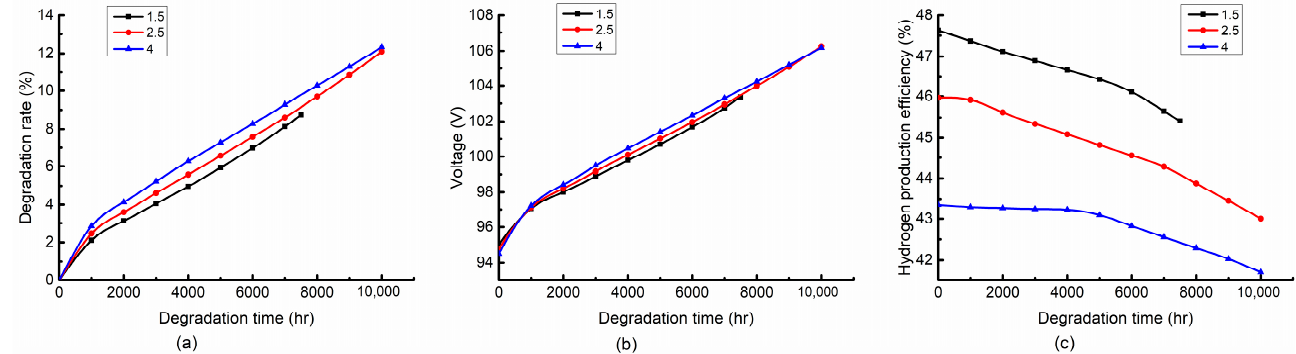
Figure 7. Variation trends of ( a ) degradation rate, ( b ) stack voltage and ( c ) hydrogen production efficiency with degradation time at air-to-fuel feed ratio of 1.5, 2.5 and 4. (Operating at 750 °C and 5000 A/m 2 ).